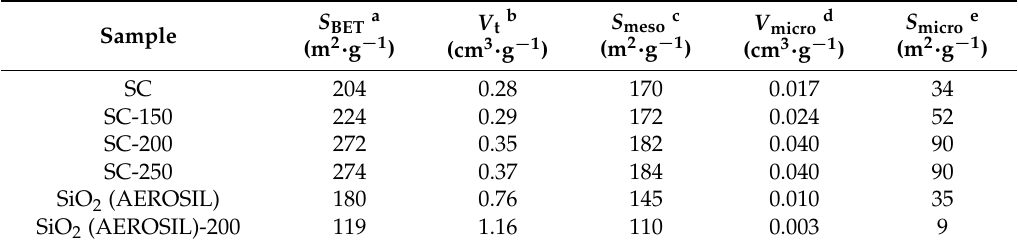
Figure 2. Pore width distribution according to Barrett, Joyner, and Halenda BJH model from isotherm adsorption branch, assuming slit ‐ shape pore geometry.